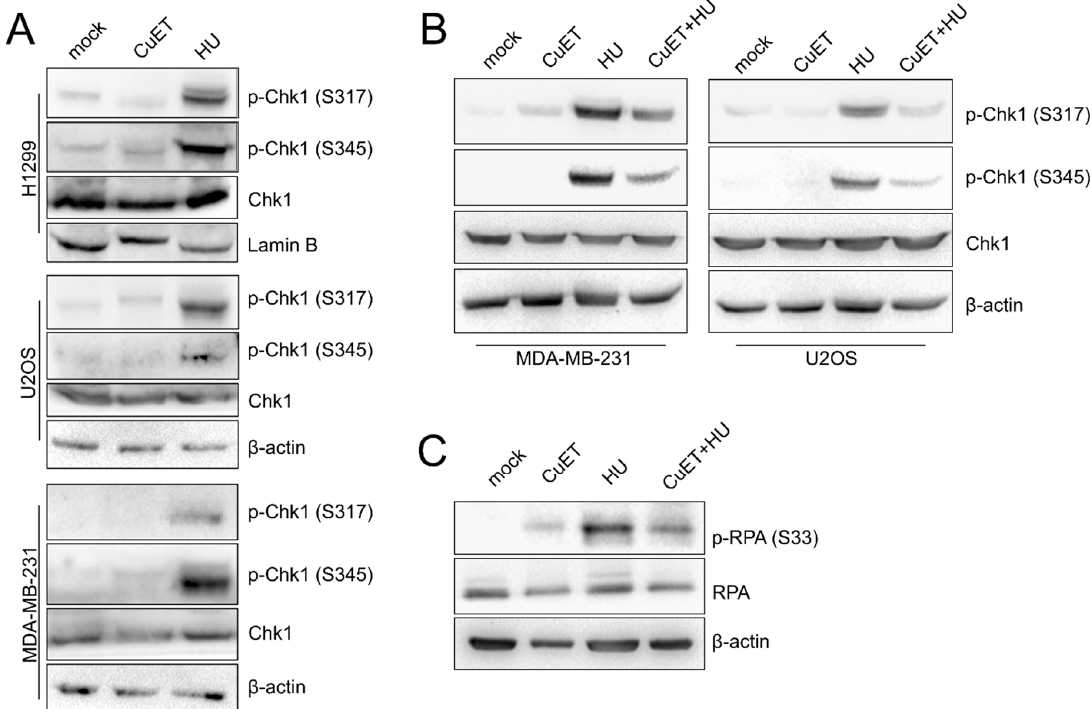
Figure 4. ATR signaling is compromised by CuET. ( A ) Western blotanalysis of phosphorylated forms of Chk1 in various cell lines treated by CuET (250 nM) or HU (2 mM) for 5 h. ( B ) WB analysis of Chk1 phosphorylation in U2OS and MDA-MB-231 cells pre-treated by dimethylsulfoxide (DMSO, mock) or CuET (250 nM) for 2 h and then exposed to HU (2 mM) for additional 3 h. ( C ) WB detection of RPA32 phosphorylation in U2OS cells treated as in B.